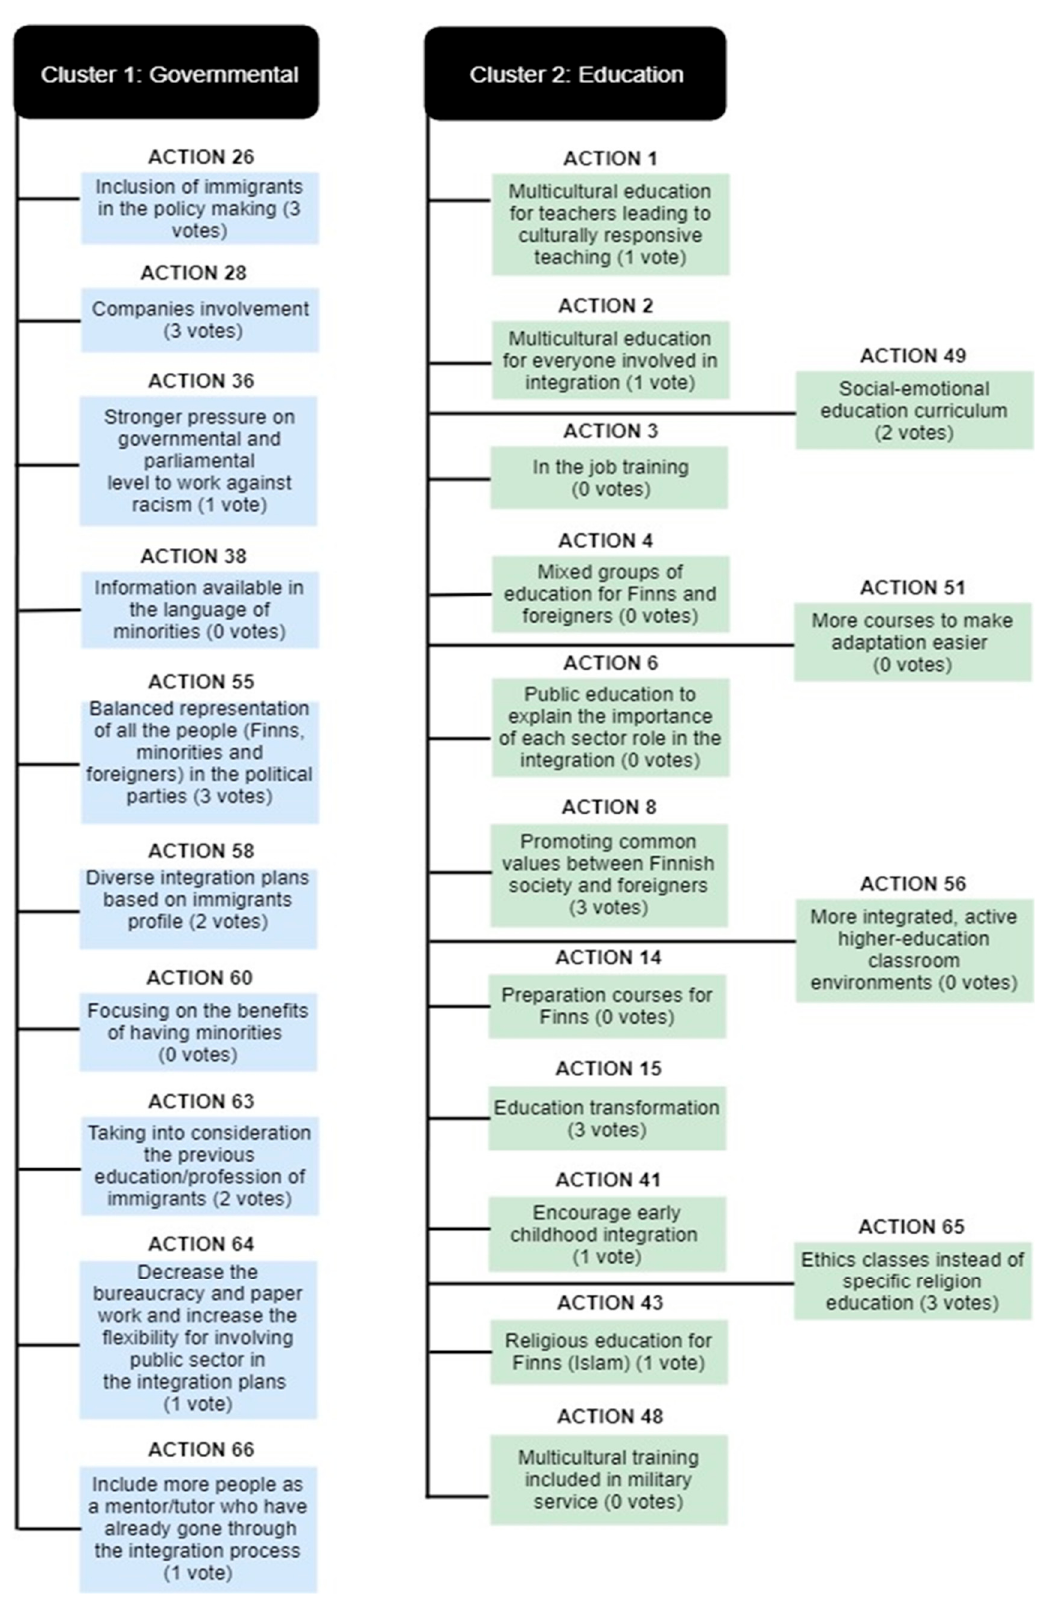
Figure 2. Clusters 1–2 of the proposed actions.